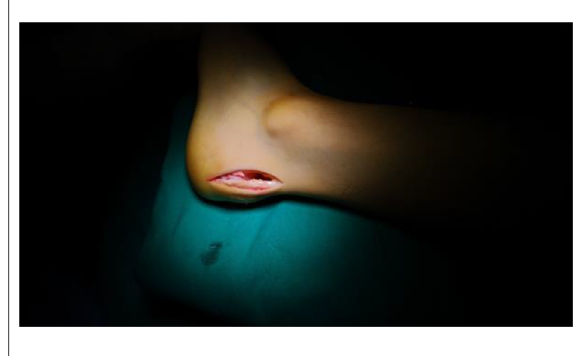
FIGURE 1 The lateral incision approach: 5 mm anterior to the lateral border